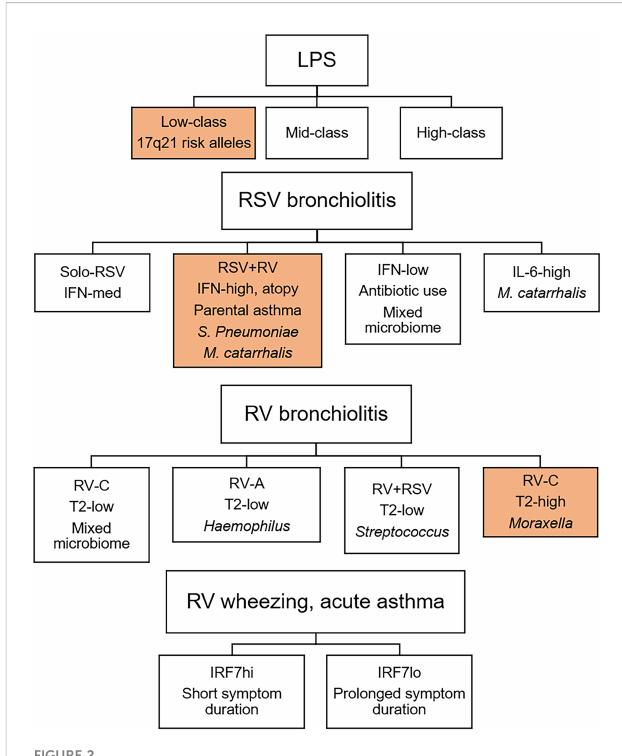
FIGURE 2 Innate immune response endotypes of viral bronchiolitis, wheezing, and childhood asthma exacerbations. Innate immune response patterns are heterogeneous and can be divided into discrete endotypes. Importantly, response pro fi les to LPS, RSV bronchiolitis, and RV bronchiolitis are differentially associated with later asthma (35, 36, 91). Children with innate immune response pro fi les shaded in orange are at increased risk for subsequent asthma. In older children, IRF7 phenotypes during RV-induced wheezing or asthma exacerbations determine symptom duration